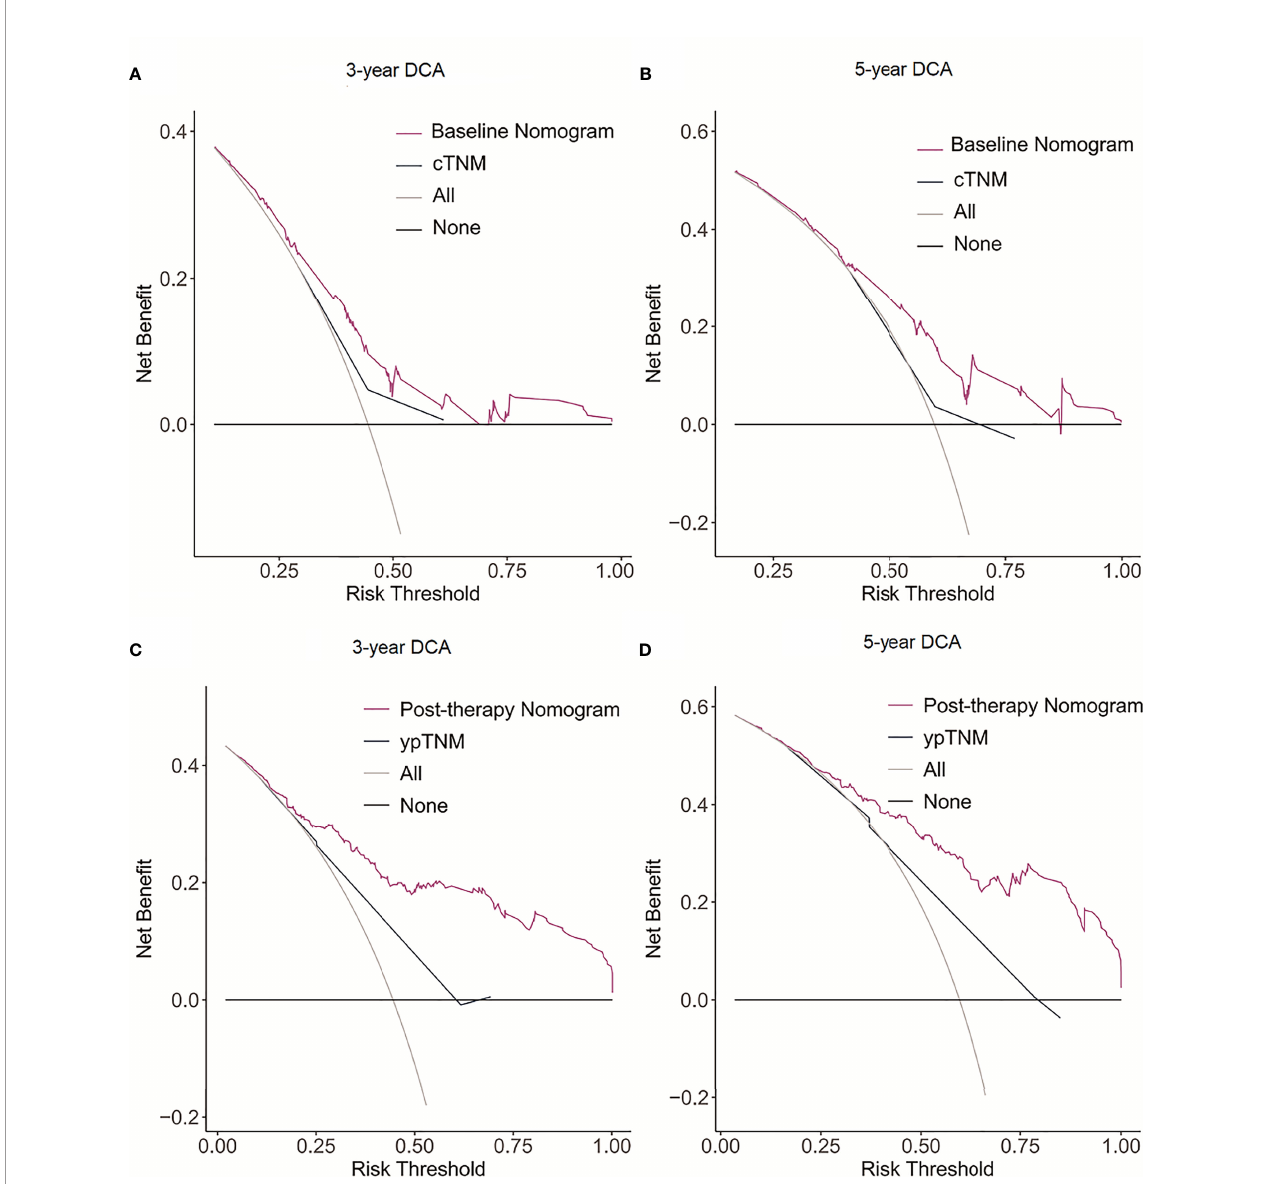
FIGURE 5 | Decision curve analysis (DCA) of the nomogram model and AJCC staging model for predicting 3- and 5-year DFS. (A) 3-year DCA for baseline nomogram and cTNM staging. (B) 5-year DCA for baseline nomogram and cTNM staging. (C) 3-year DCA for post-therapy nomogram and ypTNM staging. (D) 5- year DCA for post-therapy nomogram and ypTNM